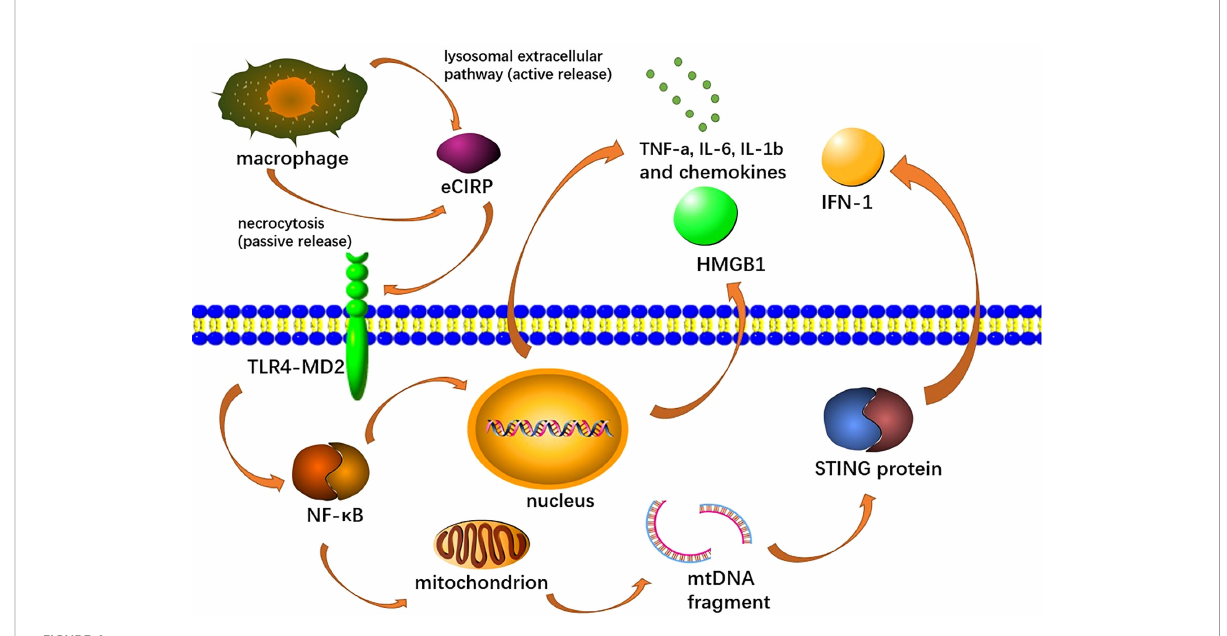
FIGURE 4 Extracellular CIRP (eCIRP) is released to the extracellular space via necrosis or lysozyme extracellular pathway, afterward binds to the TLR4-MD2 receptor complex on macrophages, activates the TLR4/MyD88/NF- k B pathway and induces macrophages to release pro-in fl ammatory cytokines (TNF-A, IL-6, Il-1b), chemokines (keratinocyte chemical attractor and MIP-2), and HMGB1. This pathway also promotes mitochondrial DNA damage and degradation, leading to STING activation, which leads to the production of type I IFN and pro-in fl ammatory